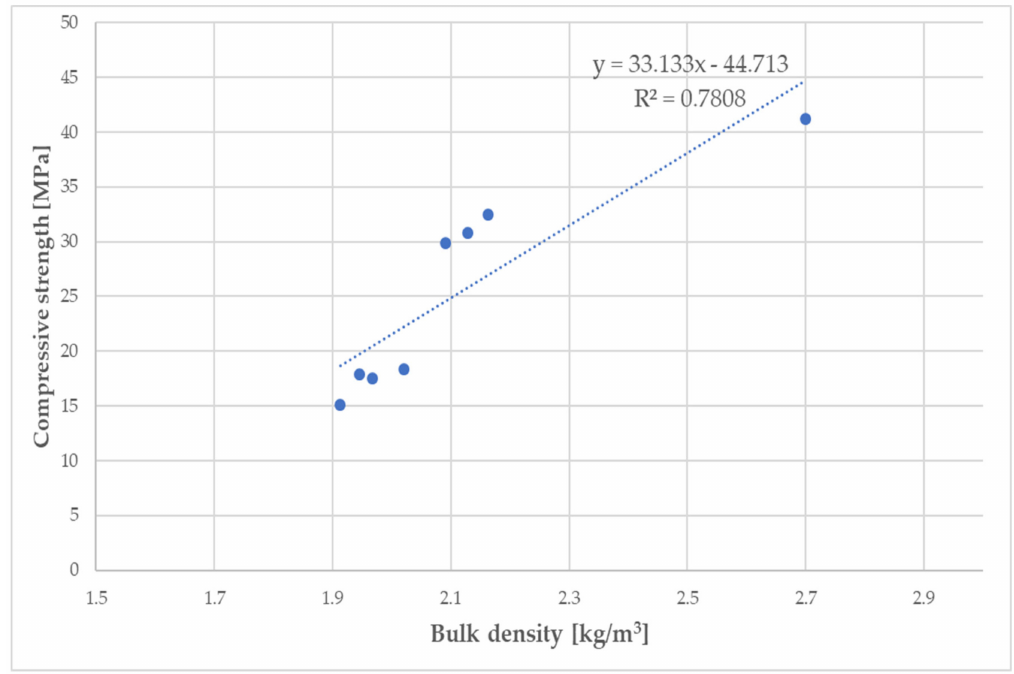
Figure 19. Linear dependence of compressive strength on bulk density of fiber-cement mortar samples (C1–C7).